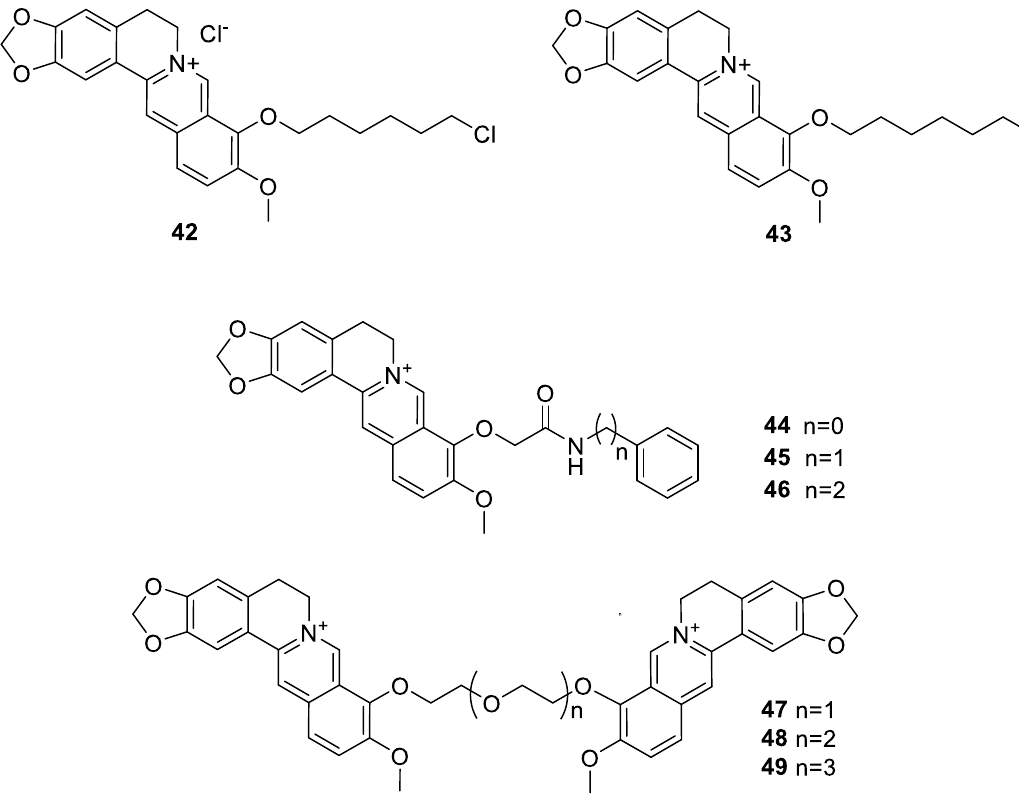
Figure 5. Further berberine- 9- O -derivatives